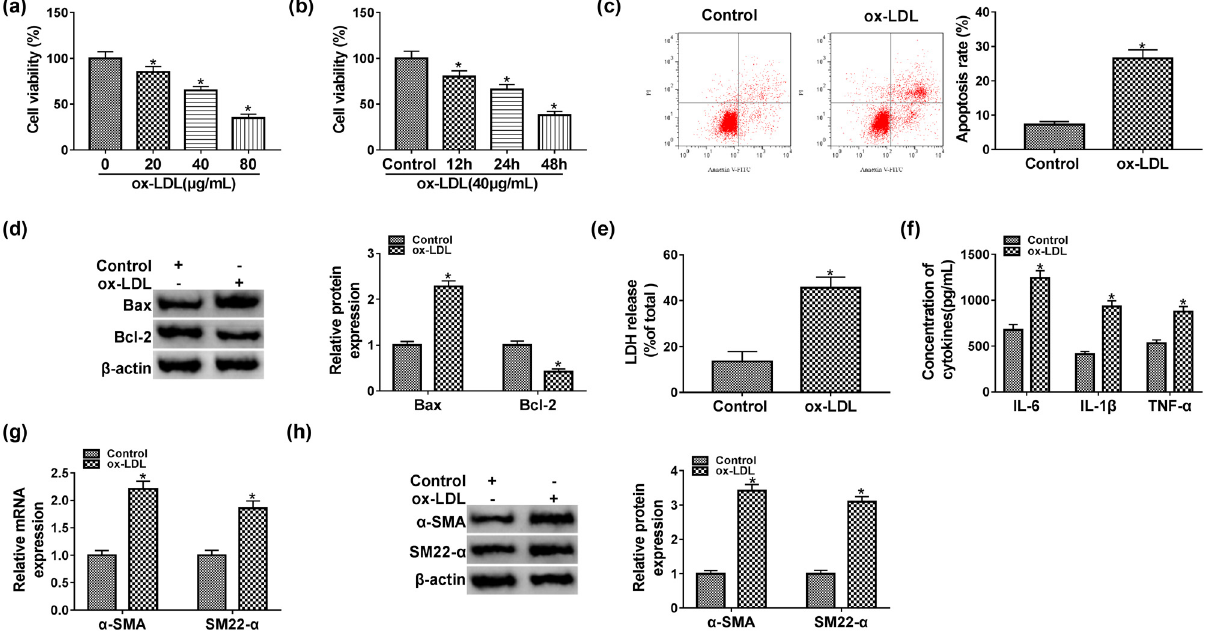
Figure 1: Ox - LDL suppressed proliferation and enhanced apoptosis and in fl ammatory response in HUVECs. ( a and b ) The cell viability of HUVECs exposed to ox - LDL was assessed by MTT assay. ( c ) The fl ow cytometry assay was performed for examining the apoptosis rate of HUVECs treated with 40 μ g/mL of ox - LDL for 48 h. ( d ) The protein expression levels of Bax and Bcl - 2 were measured by western blot assay. ( e ) LDH release in the medium was examined by a commercial kit. ( f ) The levels of IL - 6, IL - 1 β , and TNF - α were evaluated in the medium by matched kits. ( g and h ) The qPCR and western blot assays were used to show the expression levels of α - SMA and SM22 - α in HUVECs treated with ox - LDL. Data shown are mean ± SD and from three independent experiments. * P < 0.05. Abbreviations: oxidized low - density lipo - protein ( ox - LDL ) , anti - BCL2 - Associated X ( Bax ) , anti - B - cell lymphoma - 2 ( Bcl - 2 ) , interleukin 6 ( IL - 6 ) , interleukin 1 β ( IL - 1 β ) , and